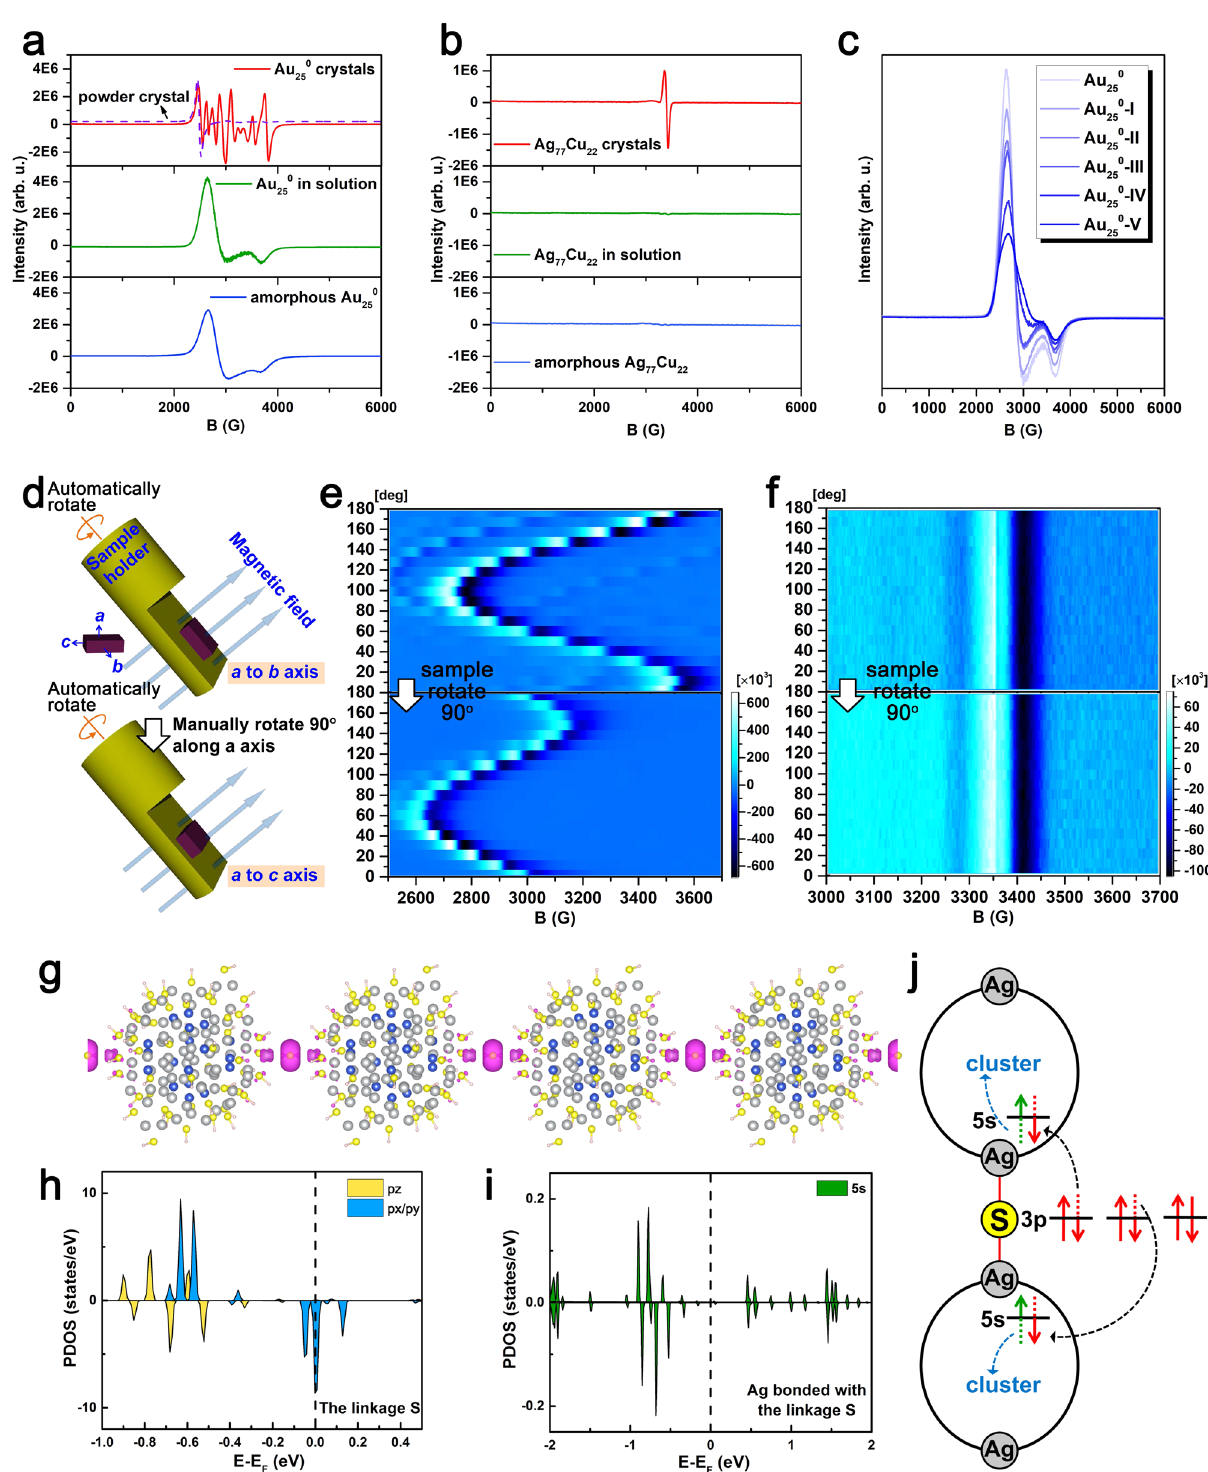
Fig.4|MagneticperformanceofAg 77 Cu 22 andAu 25 0 . EPRspectrafor a Au 25 0 and b Ag 77 Cu 22 in different states (note: the solution samples were aged for 1h before measurements, and the amorphous samples were prepared from the above-aged solutions by fast precipitation and drying). c EPR spectra measured for Au 25 0 NCs with different CHT substitution numbers. d Schematic depiction of the rotational